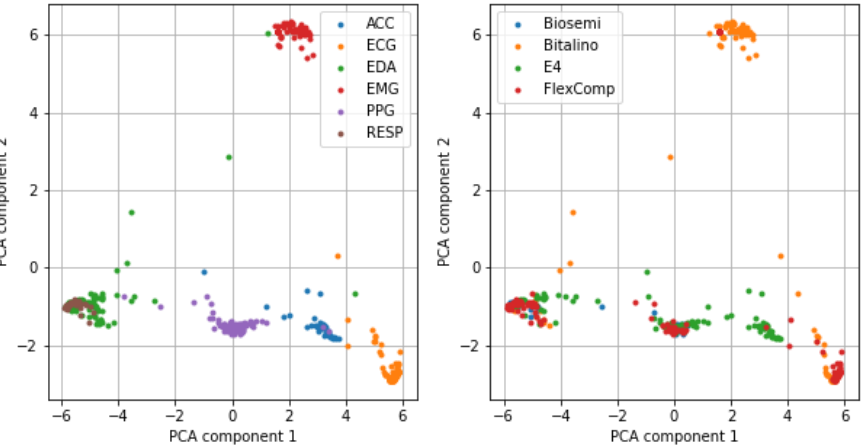
Figure 3. Representation of the input samples in the two-dimensional space defined by the Principal Component Analysis (PCA) of the extracted features. Left : colored by type of signal; Right : colored by type of device.